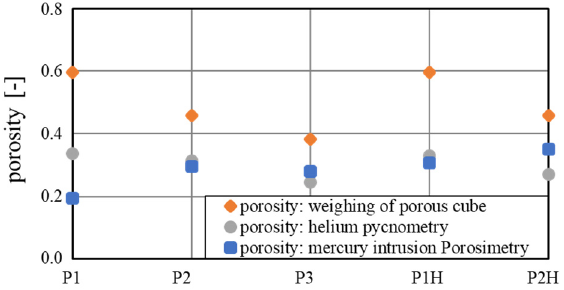
Figure 10. Measured porosities of porous wick concepts by weighting of a porous cube, helium pycnometry, and mercury intrusion